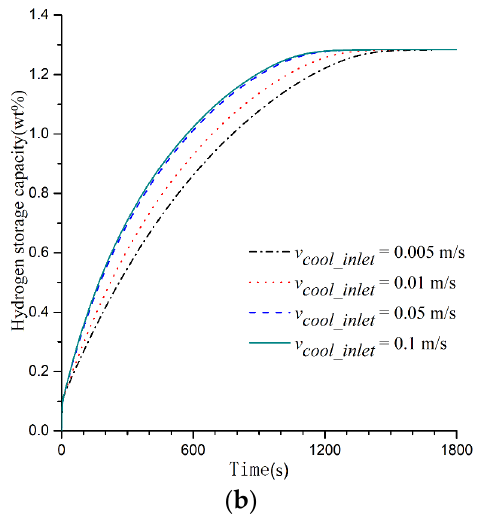
( b ) Figure 6. Temperature and hydrogen storage capacity distribution at different times of the reaction tank subjected to a cooling water flow rate of 0.01 m/s. ( a ) Temperature distribution cloud chart; ( b ) Hydrogen storage capacity distribution cloud chart. As shown in Figure 7, time-varying curves of average temperature and hydrogen storage percentage by weight are portrayed for the reaction zone filled with cooling wa- ter at four different flow rates (i.e., 0.005 m/s, 0.01 m/s, 0.05 m/s, and 0.1 m/s). According to Figure 7a, the average temperature can be rather high in the hydrogen storage tank where the cooling water flow rate is comparatively low. However, with a rise in the flow rate, differences in average temperatures in the reaction zone become increasingly small. Similarly, it is shown in Figure 7b that, when the flow rate increases, differences in the